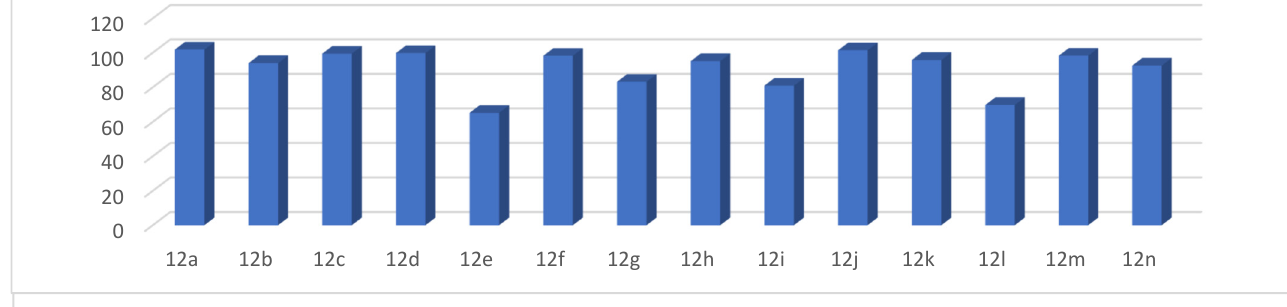
H: Mean growth % over CNS cell lines